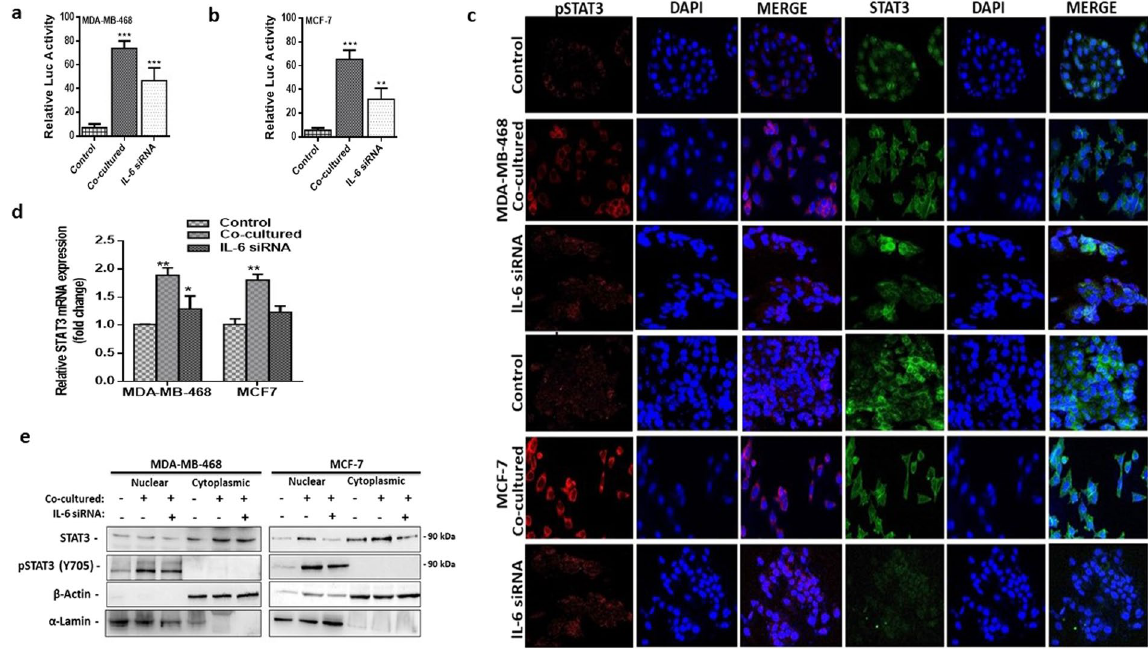
Figure 5. Adipocytes induces phosphorylated STAT3 nuclear localization. Using IL-6R siRNA and IL-6 neutralizing antibodies paracrine IL-6 signaling was blocked in co-cultured cells. ( a ) IL-6 mRNA expression was analyzed 72 hours after IL-6 signal was blocked. ( b,c ) Western blot for IL-6 in breast cancer cells over 72 hours after IL-6 signal was blocked at 24, 48 and 72 hours. Full-length blots are presented in Supplementary Fig. 5. ( d ) IL-6 mRNA expression was analyzed at 24, 48 and 72 hours in adipocytes after IL-6 siRNA transfection. ( e ) Western blot for IL-6 in IL-6 siRNA transfected adipocytes at 24, 48 and 72. Full-length blots are presented in Supplementary Fig. 5. ( f,g ) Relative luciferase activity in breast cancer cells with STAT3 luciferase reporter plasmid, with/without human adipocytes and after IL-6 was blocked. ( h ) Quantitative PCR comparing the expression of STAT3 mRNA in co-cultured breast cancer cells with/without IL-6 blocking and in control cells. Relative mRNA expression was normalized to GAPDH. ( i ) Increased STAT3 phosphorylation and nuclear localization in co-cultured human breast cancer cells with/without IL-6 neutralization and in control cells assessed by immunofluorescence staining. ( j ) Representative western blot analysis of pSTAT3 expression in cytoplasmic and nuclear fraction of co-cultured breast cancer with/without IL-6 neutralization and in control breast cancer cells. α -Lamin and β -actin was used as loading control for nuclear and cytoplasmic fraction respectively. Full-length blots are presented in Supplementary Fig. 5. All results are representative of 3 independent experiments. Data is presented as mean ± SEM; *** p < 0,001; ** p < 0.01; * p <